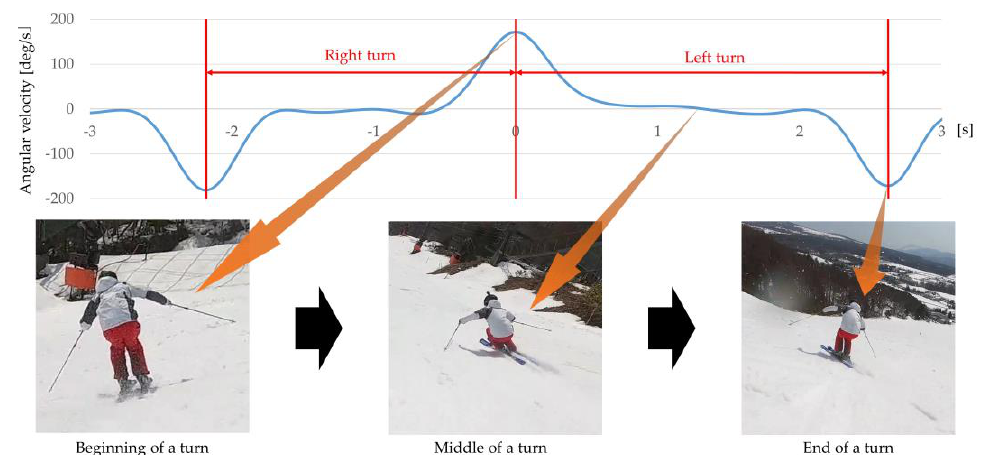
Figure 5. One phase of ski turn was extracted using the peak to peak of angular velocity around the Y axis of inertial sensor placed on the ski.